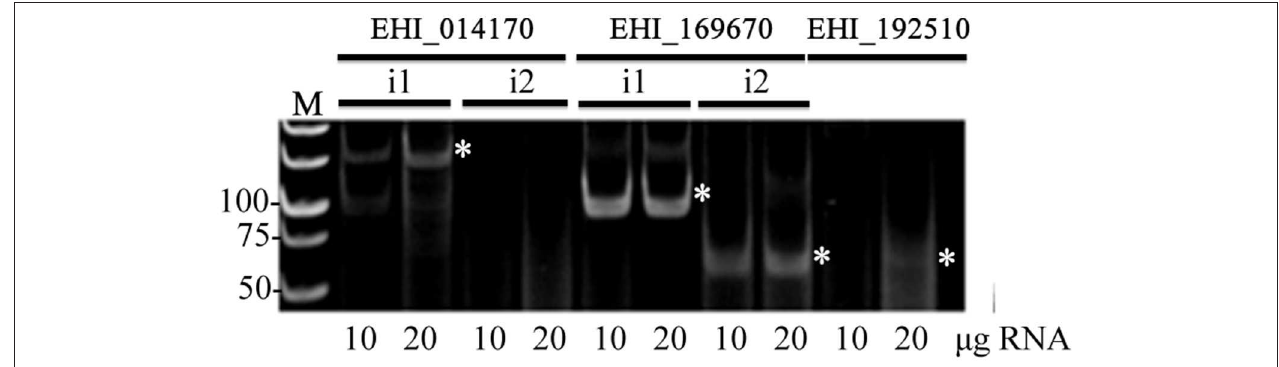
FIGURE 7 | Introns of some virulence-related genes also render flicRNAs. Appropriate sets of outward-facing primers were designed to amplify virulence-related flicRNAs (white asterisks) by circular RT-PCR as in Figure 2F . Different amounts of small RNA input isolated with the miRNA isolation kit were used. Gene accession numbers are indicated; i1, intron 1; i2, intron 2. Numbers to the left indicate the bp ladder (M).